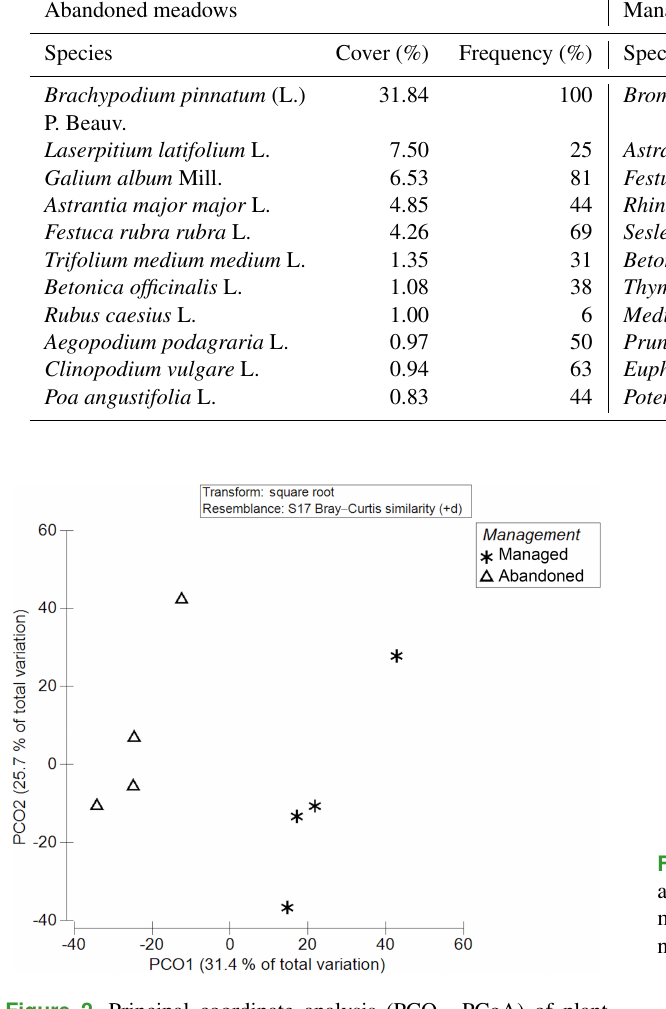
Figure 2. Principal coordinate analysis (PCO = PCoA) of plant species assemblages between managed and abandoned meadows.